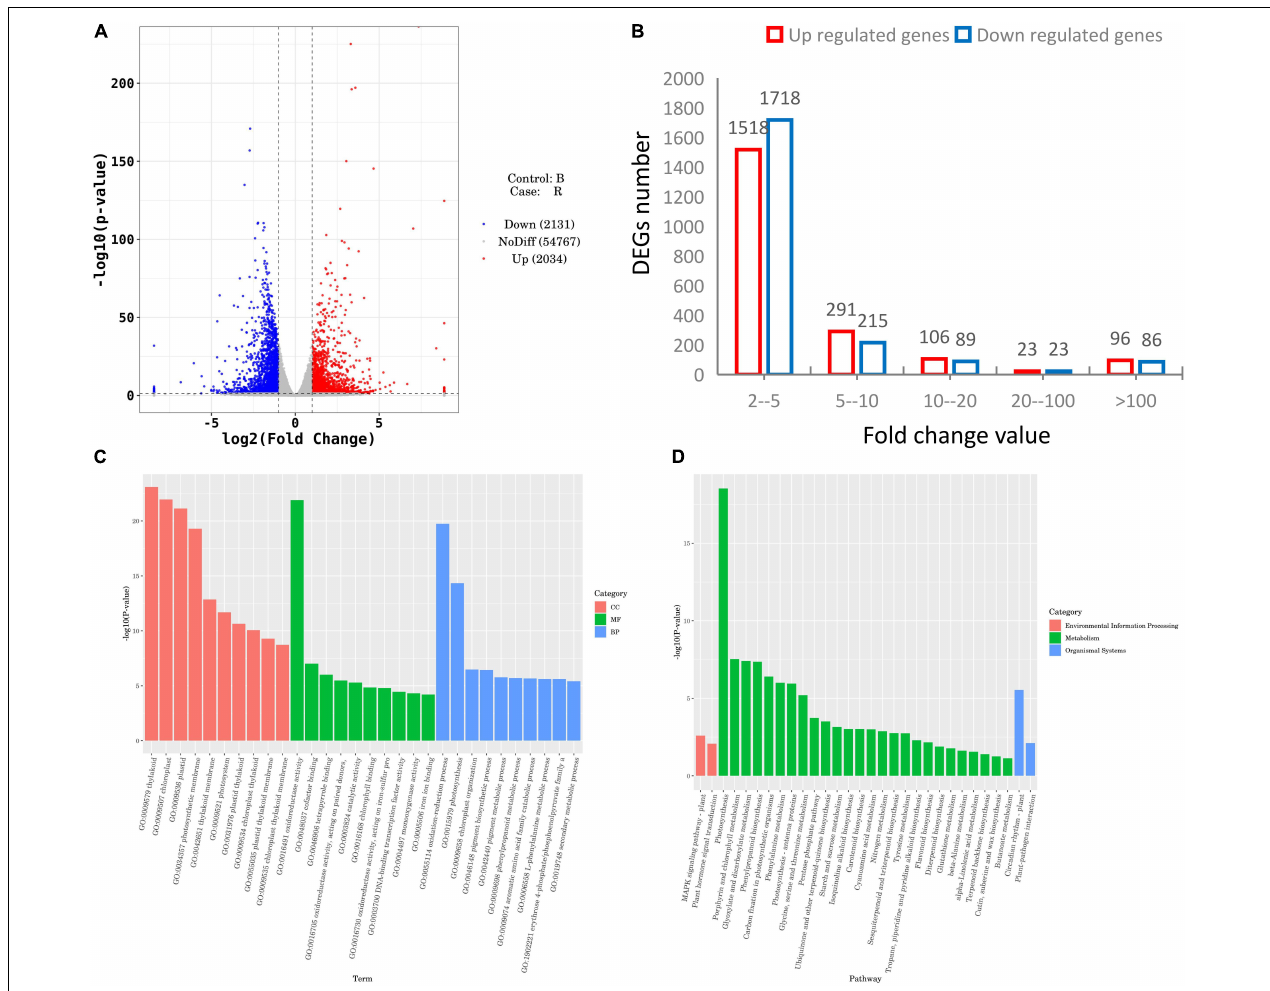
FIGURE 5 | Differentially expressed genes (DEGs) statistics and functional enrichment analysis between the red- and blue-light treatments. (A) DEGs statistical analysis; (B) Distribution of DEGs based on different fold change thresholds; (C,D) GO and KEGG enrichment analysis,